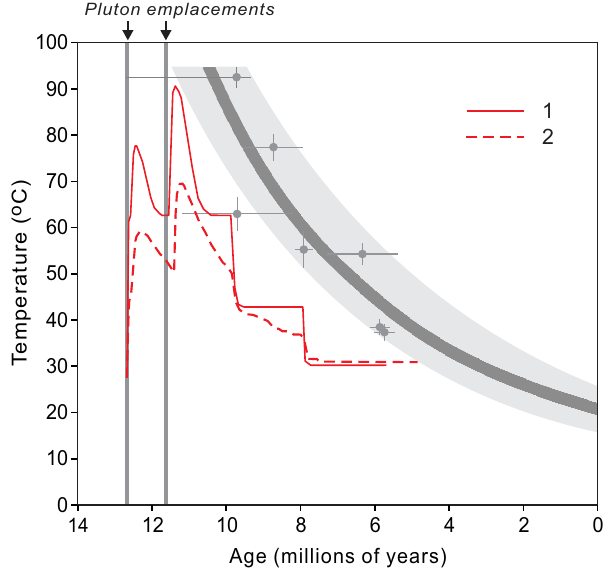
Figure A6. Sensitivity simulation illustrating the role of the UZ thickness. Temperature at reference point ( z = 300m) when: (1) UZ thickness is 500m; (2) UZ thickness is 1000m. Other model param- eters and scenario correspond to that of Whelan et al. (2008) (cf. Supplement